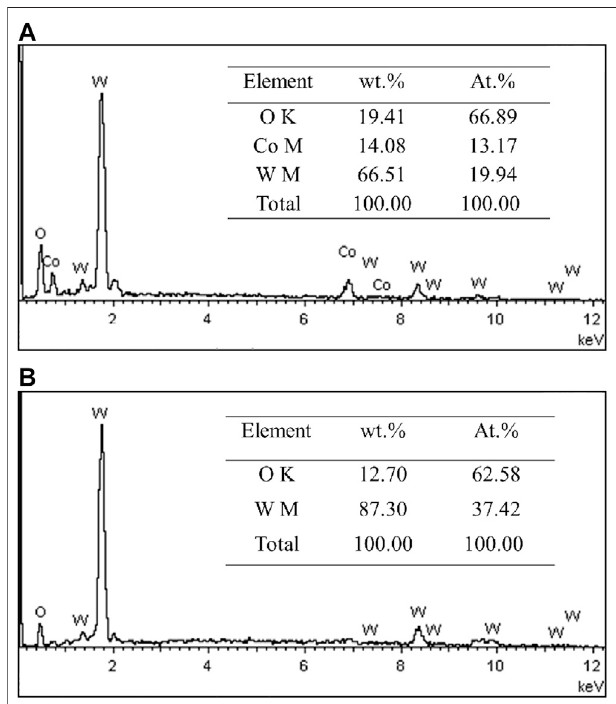
FIGURE 4 | EDS analysis results of micro zones 1 (A) and 2 (B) of YG3 shown in Figure 2L .